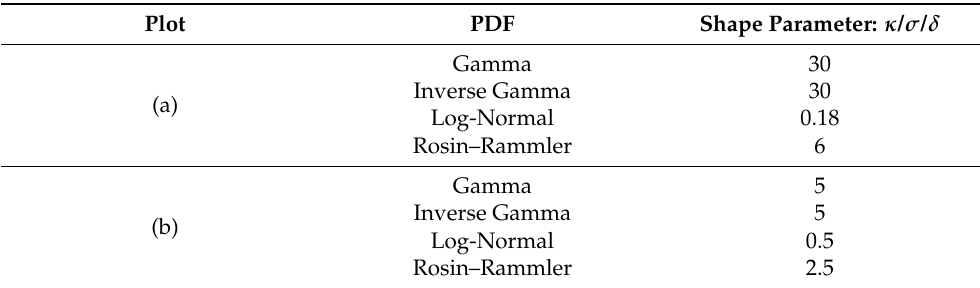
Figure A1. Initial Gamma, Inverse Gamma, Log-Normal and Rosin–Rammler probability density Figure A.20: Initial Gamma, Inverse Gamma, Log-Normal and Rosin-Rammler probability density functions (Eqs. (4.20), (4.21), (A.1), (A.2)) versus the particle radius, for various κ , σ and δ parameters (Table A.3). The β t =0 , ν t =0 and η t =0 functions (Equations (32), (33), (A1) and (A2)) versus the particle radius, for various κ , σ and δ parameters coefficients are computed via Eqs. (4.28), (A.3), (A.4), such that the initial mean radius R 2 t =0 of the polydisperse particles is (Table A1). The β t = 0 , ν t = 0 and η t = 0 coefficients are computed via Equations (40), (A3) and (A4), such t = 0 t = 0 = R 2 t =0 = 10 µ m. that the initial mean radius R 2 of the polydisperse particles is R 2 10 µ m. Table A1. Various parameters of the Gamma, Inverse Gamma, Log-Normal and Rosin–Rammler PDFs displayed in Figure A1. Plot PDF Shape Parameter: κ / σ /